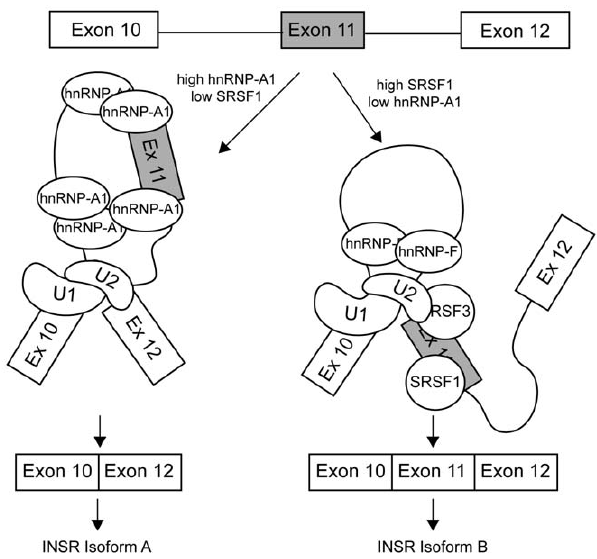
Figure 7. Model for antagonistic regulation of exon 11 inclusion by hnRNP A1 and hnRNP F/SRSF1. When hnRNP A1 is highly expressed compared to SRSF1, binding of hnRNP A1 to the 5 9 splice site of intron 11 and the intronic elements blocks recognition of the exon by the splicing apparatus causing skipping of the exon. When hnRNP A1 is low compared to SRSF1, binding of SRSF1 to the exon prevents binding of hnRNP A1 allowing binding of SRSF3 and hnRNP F that promote exon